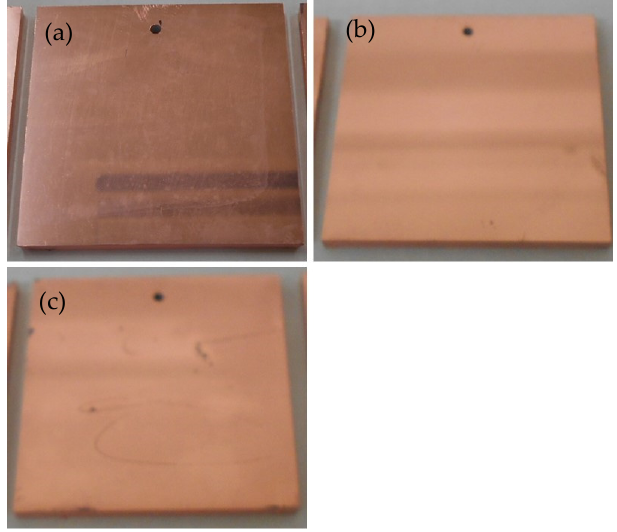
Figure 3. Exterior pictures of Pd/ABS samples after electroless Cu plating: ( a ) Pd/ABS 0 vol%, ( b ) Pd/ABS 1 vol%, and ( c ) Pd/ABS 10 vol%.